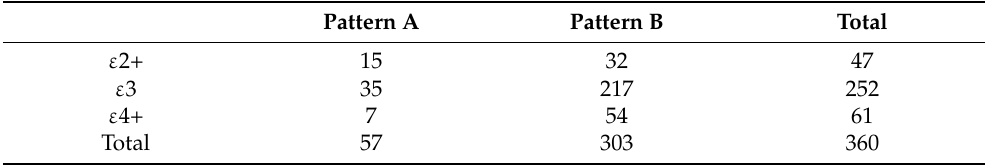
Table 2. APOE genotypes and LDL density patterns in 360 patients.